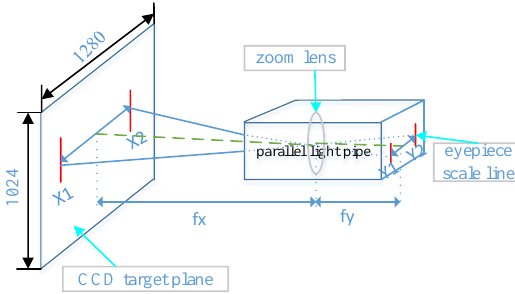
Figure 7. Measuring focal length diagram.